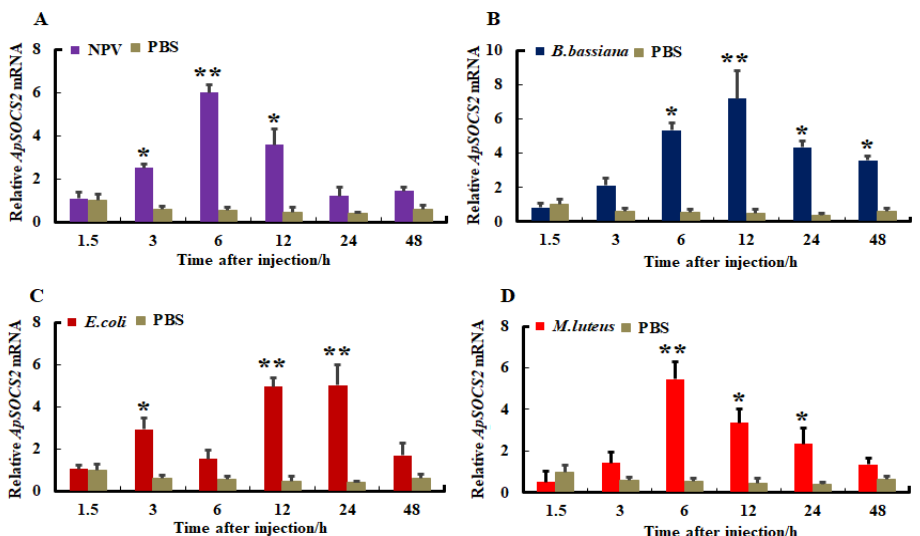
Figure 5. The mRNA expression levels of ApSOCS-2 in fat bodies following microbial challenge normalized to 18 S and actin-1 (Actin-1 normalized: Figure S3). Following injection of ( A ): ApNPV, ( B ): B. bassiana , ( C ): E. coli , ( D ): M. luteus , the mRNA expression levels of ApSOCS-2 were analyzed using qRT-PCR. Data of triplicate experiments (n = 3) are represented with mean ± S.E. Asterisks indicate significant differences (* p < 0.05, ** p < 0.01).